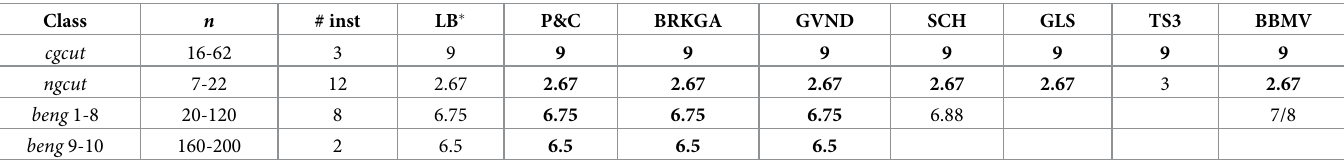
Table 11. Comparison of the solutions obtained by the different approaches for the cgcut , ngcut , and beng instances without rotations.